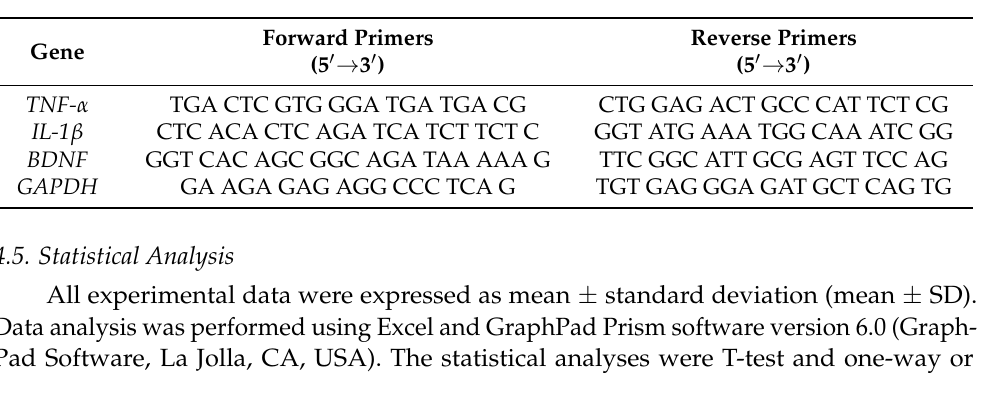
Table 3. Primer sequences used for qRT-PCR